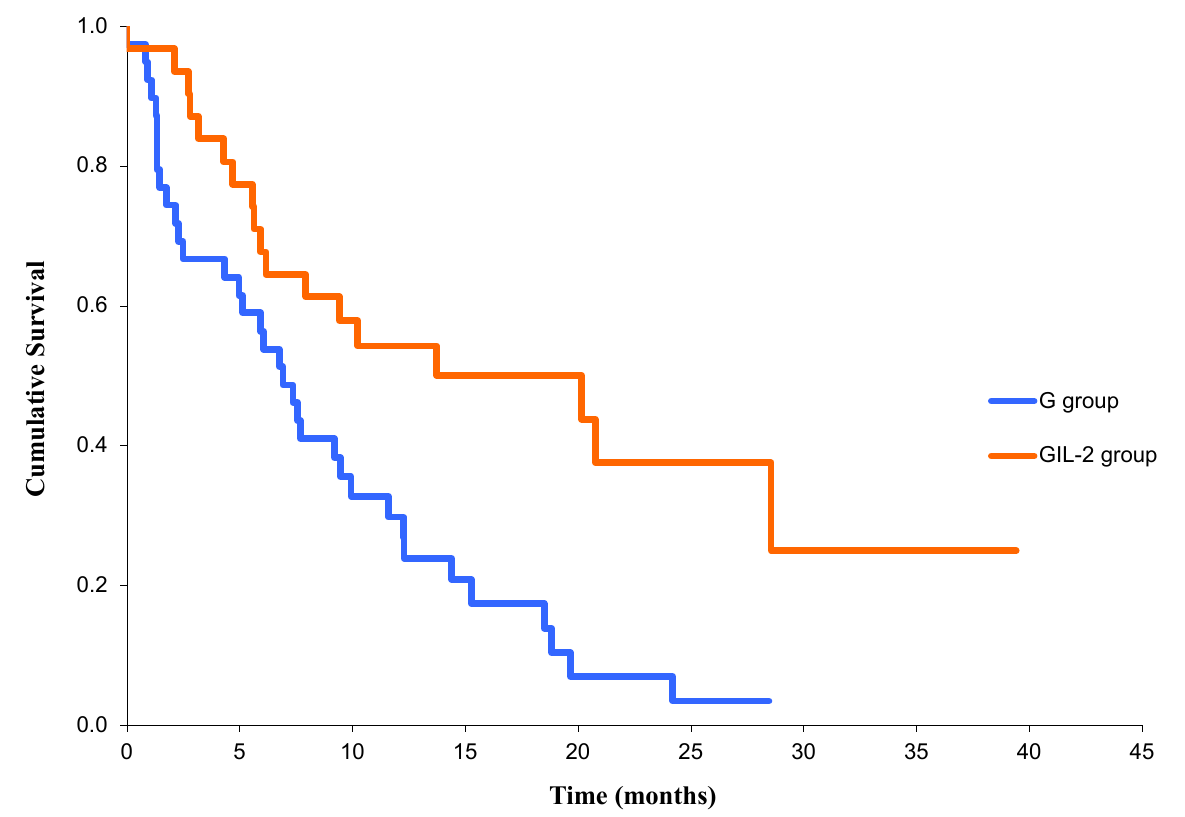
Figure 2. Overall survival in G and GIL-2 groups ( p = 0.002).